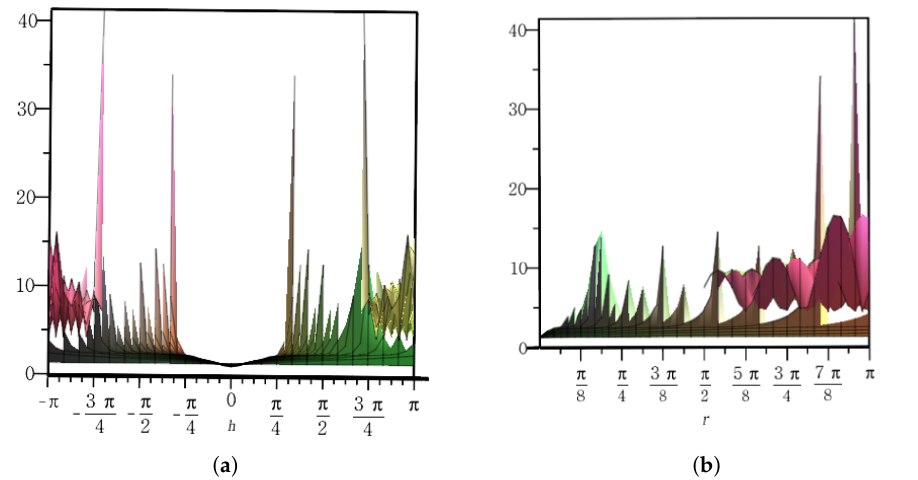
Figure 8. ( a ) Side view of Figure 7 observed in the direction perpendicular to h ( − π ≤ h ≤ π ). ( b ) Side view of Figure 7 observed in the direction perpendicular to r (0 ≤ h ≤ π